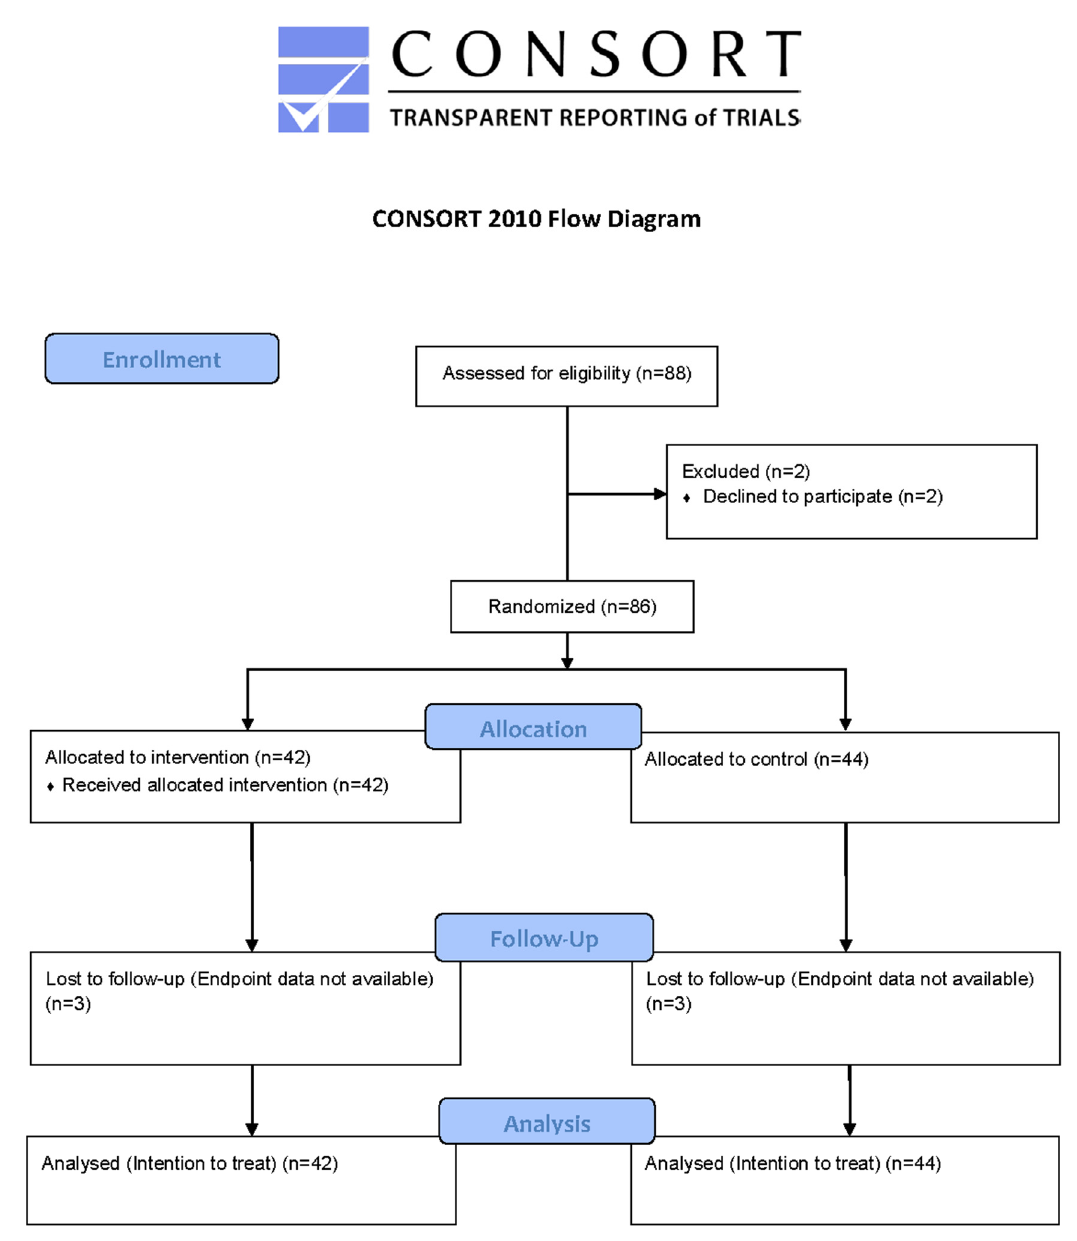
Figure 1. Study flow chart (CONSORT).